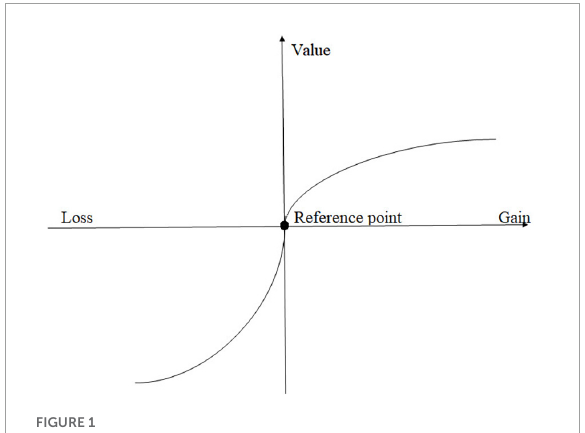
FIGURE1 The value function [adopted from Tversky and Kahneman